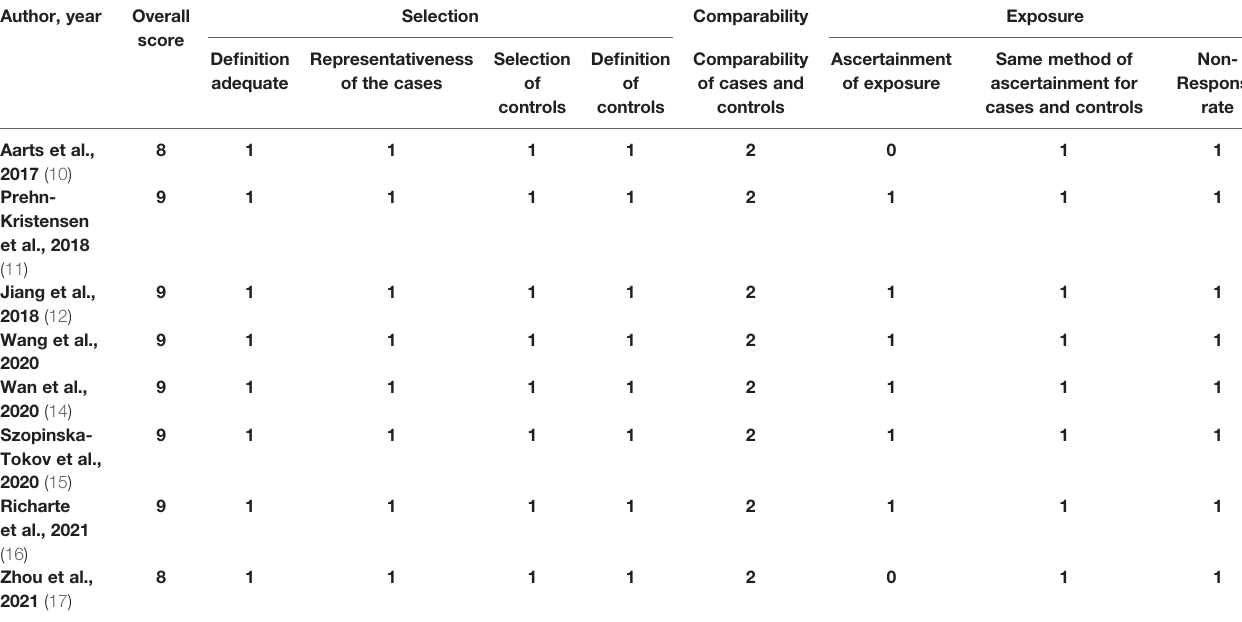
TABLE 2 | Newcastle – Ottawa Scale for assessing the quality of the studies included in the meta-analysis.